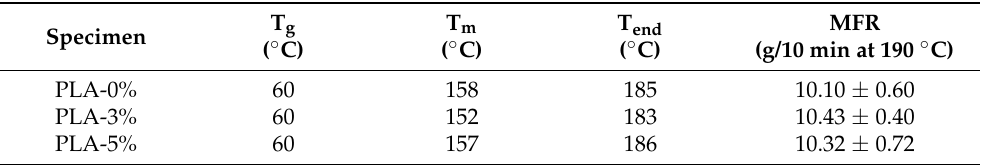
Table 2. Glass transition temperature, melting temperature, endset temperature, and melt mass-flow rate of neat PLA, PLA-3%, and PLA-5% CaCO 3